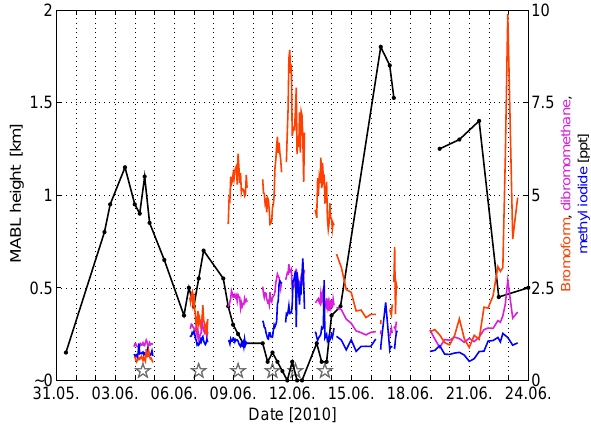
Fig. 11. Comparison of MABL height (left scale, in km) with bro- moform, dibromomethane and methyl iodide mixing ratios (right scale, in